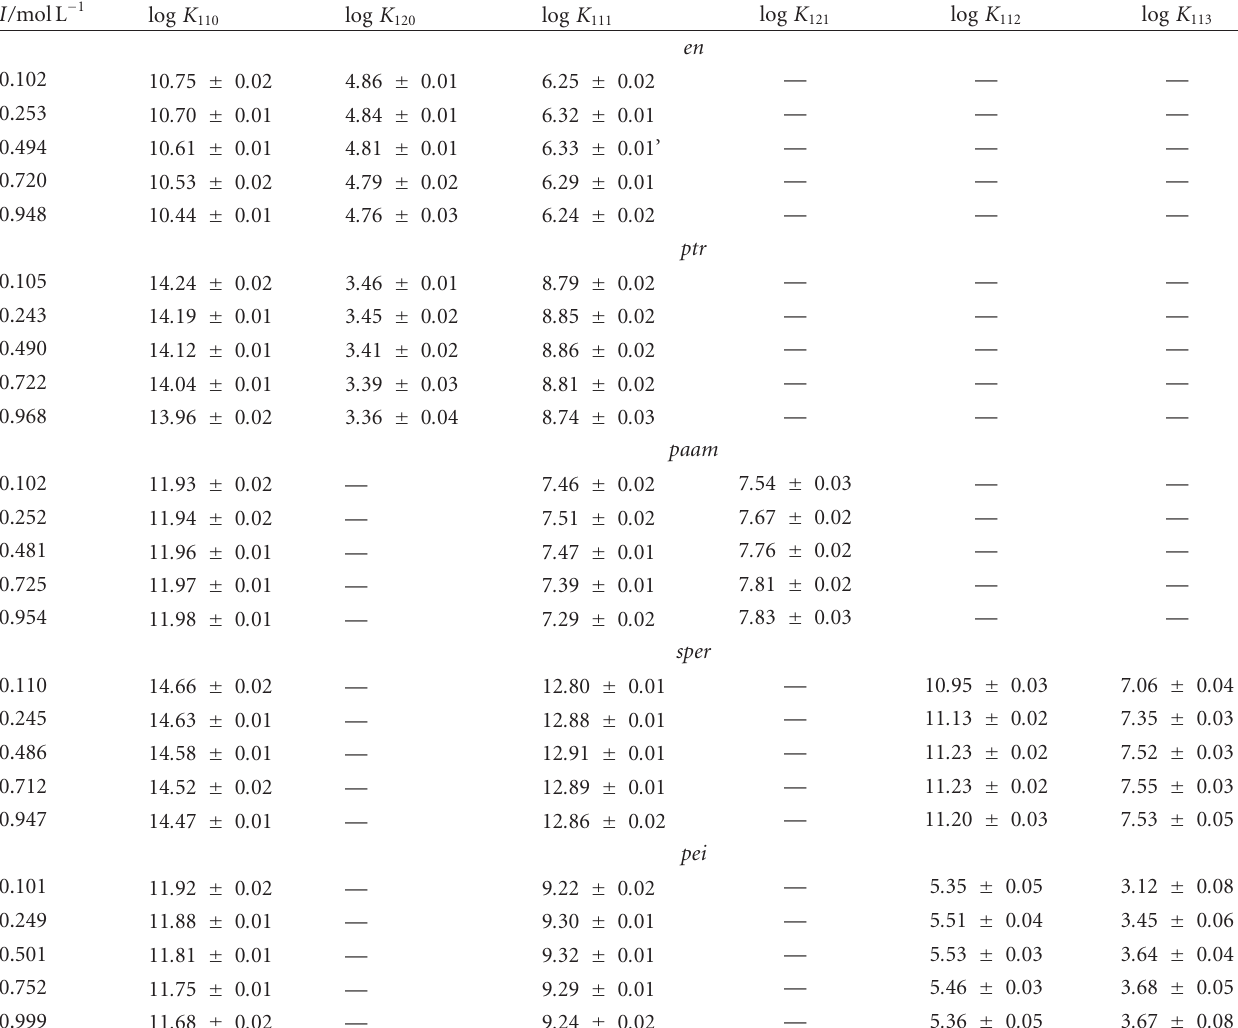
Table 2: Stability constants of dimethyltin(IV)/amine species, in NaCl aq at di ff erent ionic strengths (in mol L − 1 ) and t = 25 ◦ C. log K pqr refer to equilibria reported in (2)–(4); ± standard